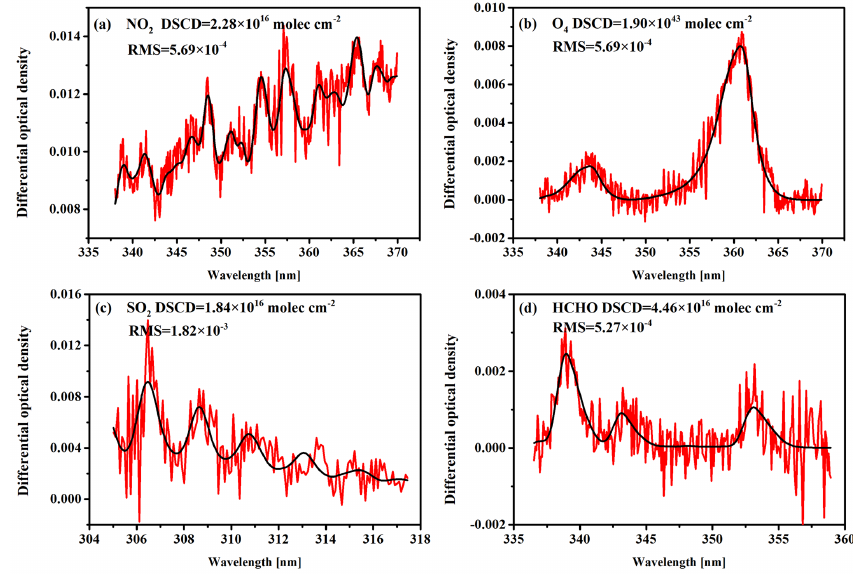
Figure 2. Typical DOAS spectral fittings for (a) NO 2 , (b) O 4 , (c) SO 2 , and (d) HCHO. The spectrum was collected at an elevation of 15 ◦ at 10:13LT on 7 June 2017. The black curves show the reference absorption cross section scaled to the measured atmospheric spectrum (red curves) by DOAS